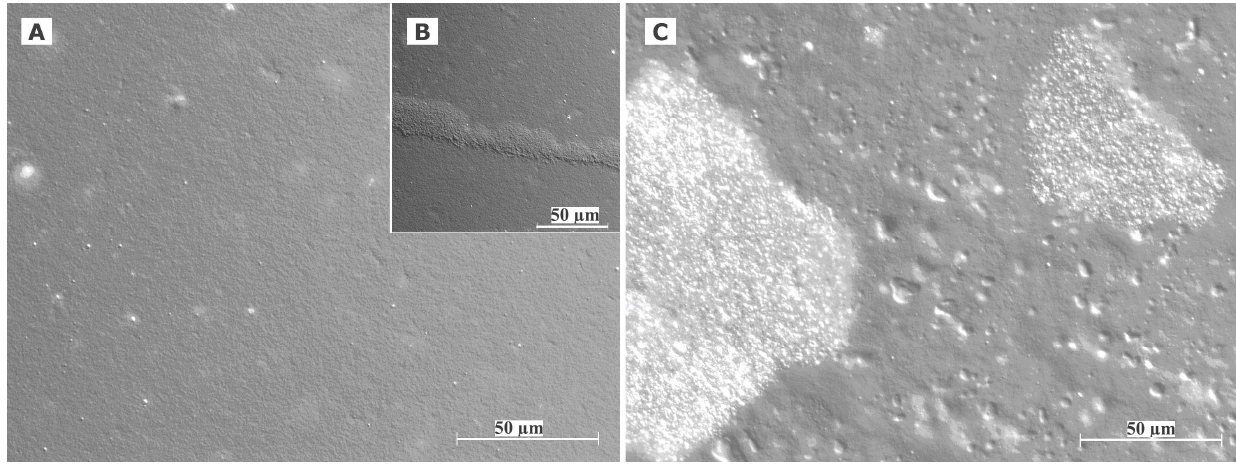
Figure 4. Images of fresh, as well as stored, nanoemulsions as observed by optical light microscopy. All images were taken with 40 x magnification/DIC. Image 4A shows the blank nanoemulsion directly after preparation. Figure 4C shows the same formulation after 6 months of storage. Image 4B shows an artefact obtained with a fresh nanoemulsion sample due to evaporation effects on the object slide. The indicated scale bars represent 50